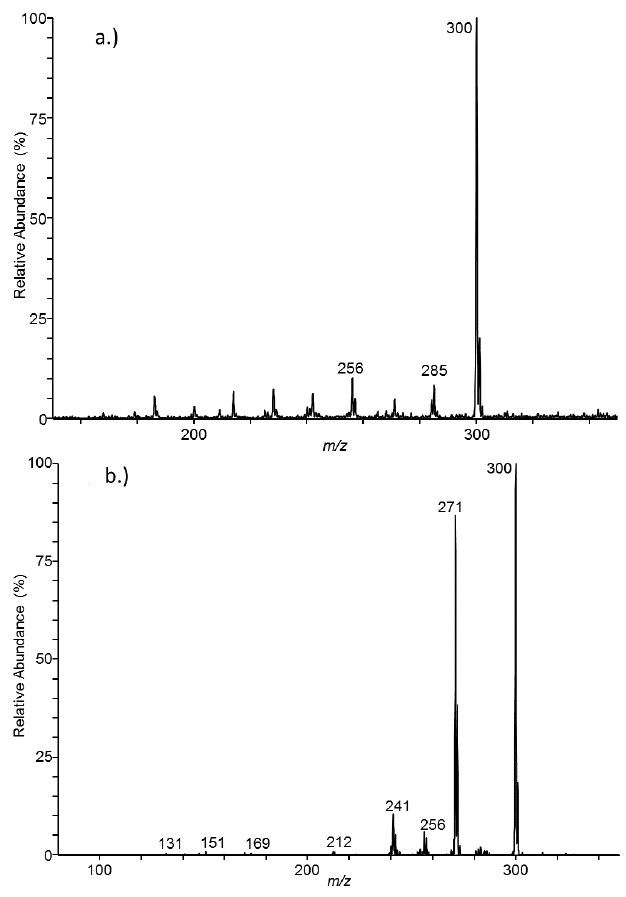
Figure 2. ( a ) MS and ( b ) MS/MS spectra for 8- O -methylbostrycoidin.